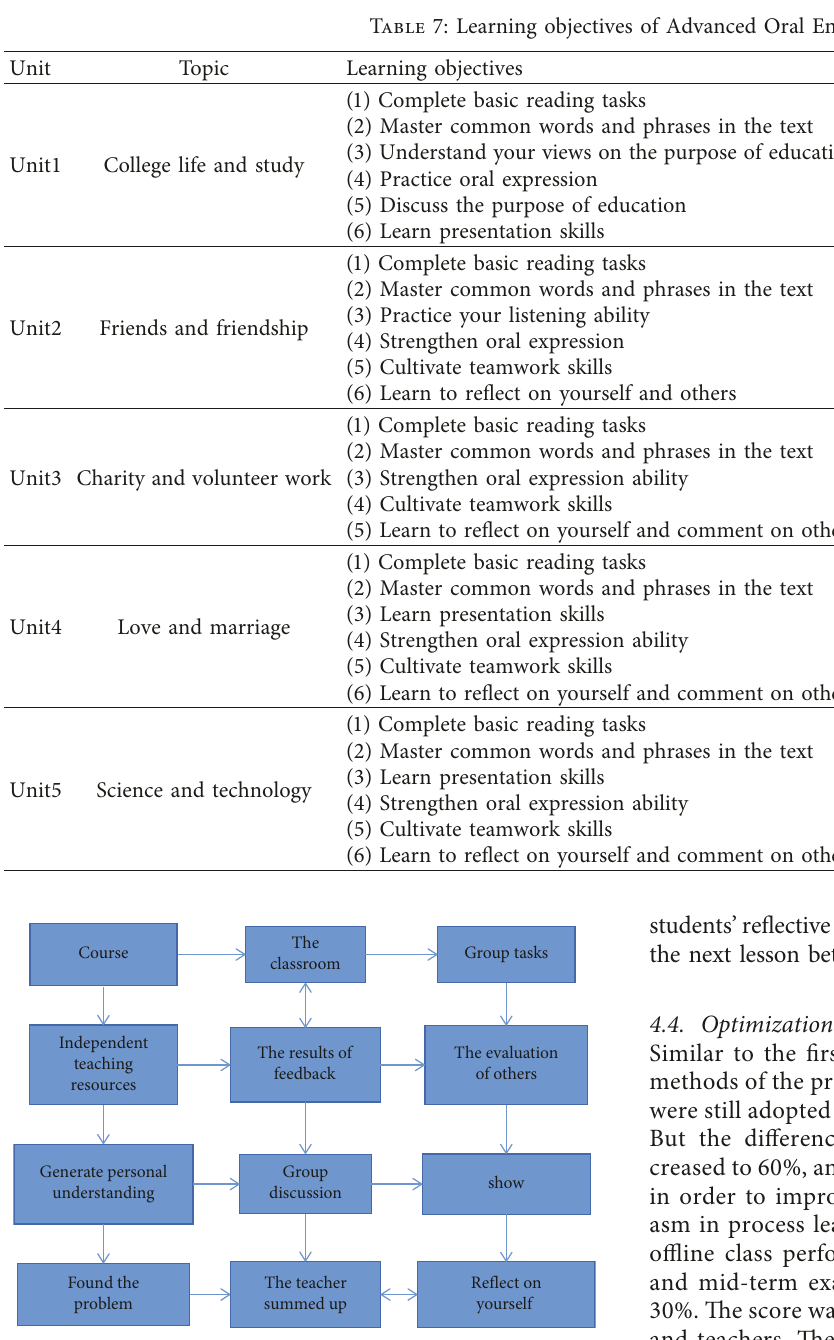
Figure 7: Optimization diagram of mixed teaching